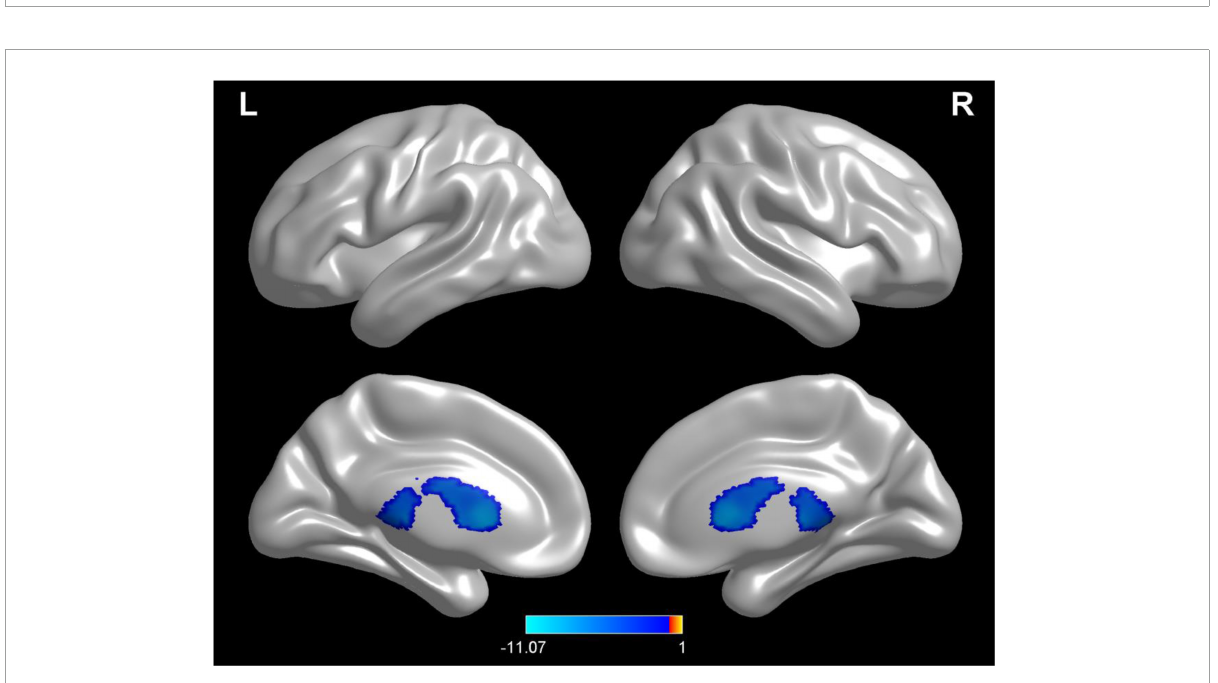
FIGURE5 Regional changes on the voxel-based three-dimensional displayed brain cerebrospinal fluid among participants when compared with test 3 in rehydration state and test 2 in dehydration state. Warm colors mean that the cerebrospinal fluid density among participants in the rehydration test was higher than that in the dehydration test; cold colors mean that the cerebrospinal fluid density among participants in the rehydration test was lower than that in the dehydration test; p < 0.05 after false-discovery rate correction, voxel threshold of cluster >